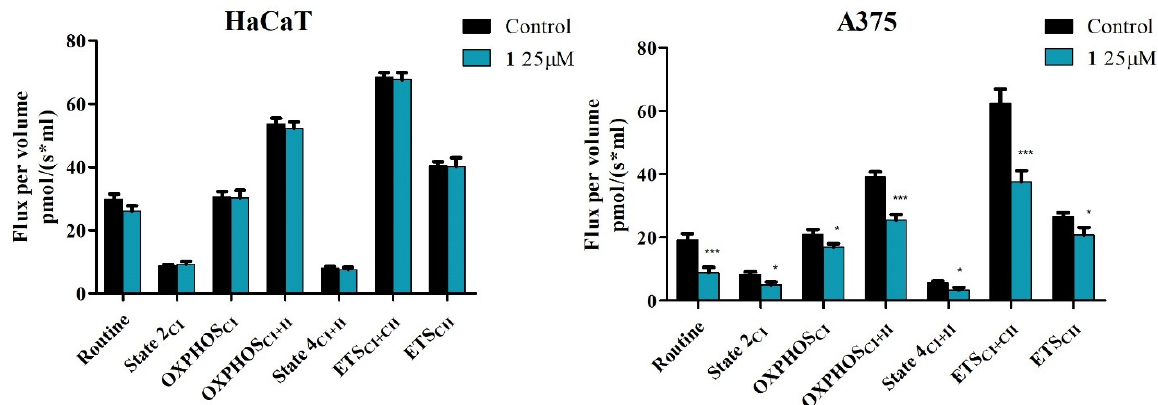
Figure 8. Respiration of permeabilized immortalized human keratinocytes (HaCaT) and human melanoma cells (A375) following a 24 h stimulation with 25 μ M 1 . Data represent the mean ± SD of five individual experiments. Values with p < 0.05 were considered to have statistically significant differences (* p < 0.05, and *** p < 0.01). The respiratory parameters displayed represent the following: Routine—respiration of cells suspended in a substrate-free media, supported by endogenous ADP; State 2 CI —mitochondrial respiration in basal conditions driven by CI, OXPHOS CI —active respiration dependent on CI substrates and exogenous ADP; OXPHOS CI+II —maximal active respiration driven by both CI and CII; State 4 CI+II —basal respiration dependent on both CI and CII; ETS CI+II —maximal respiratory capacity of the electron transport system in the fully noncoupled state; ETS CII —electron transport system maximal capacity dependent only on CII.